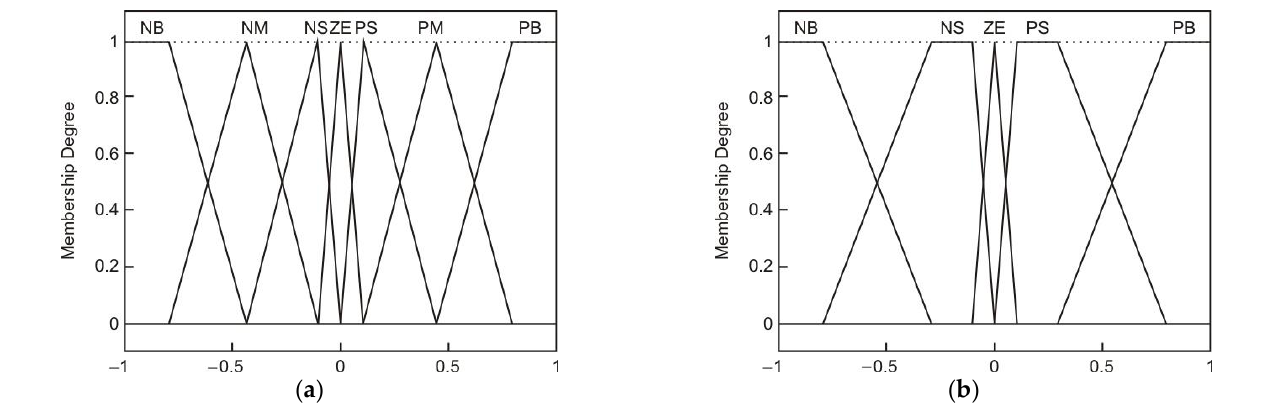
Figure 7. The dynamic control scheme.